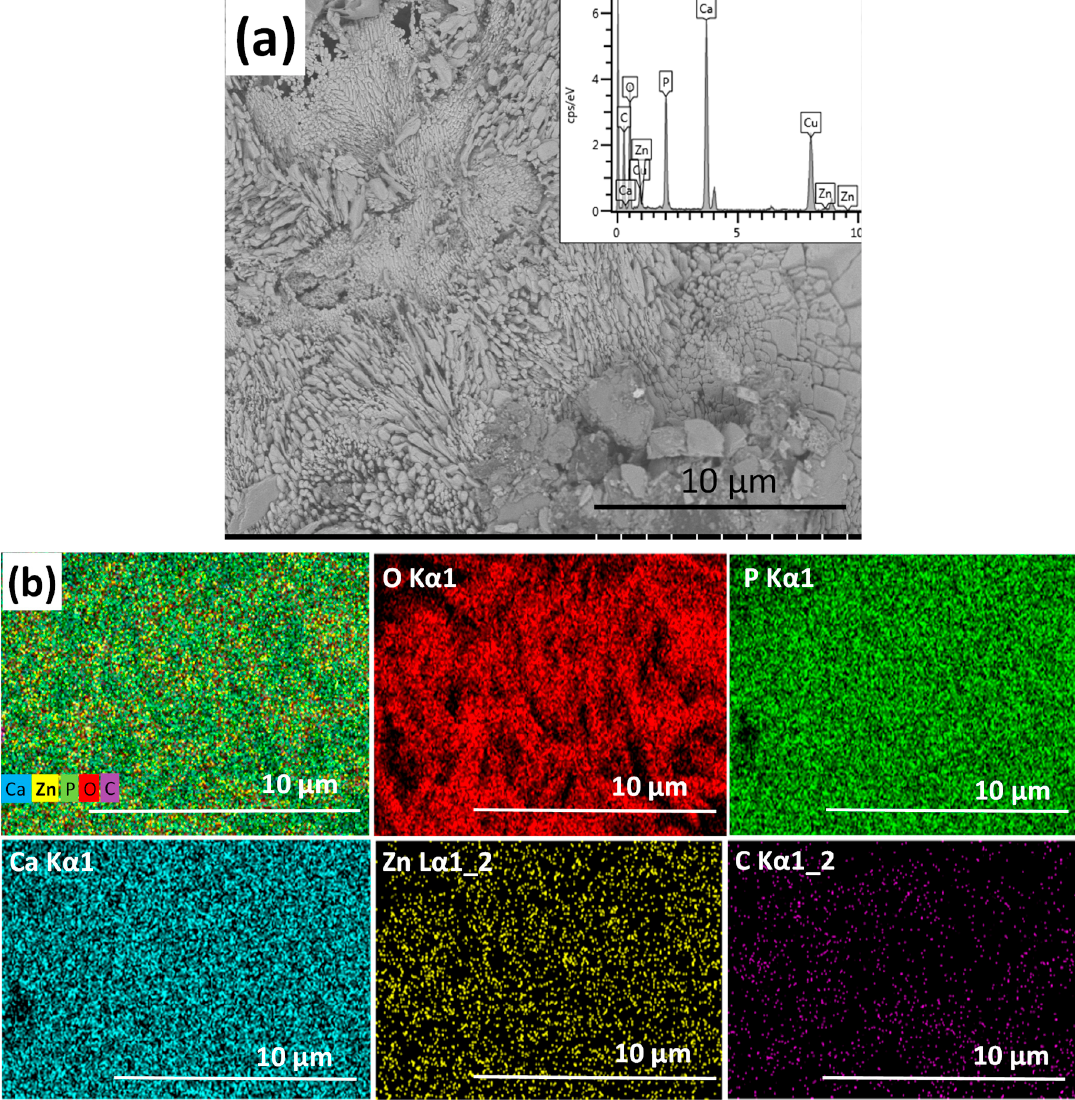
Figure 2. SEM image of zinc-containing CP coating. ( a ) Magnification: 5.0 k, working voltage: 2.0 kV, working distance: 4.1 mm, and the corresponding map sum EDX spectrum (inset) and ( b ) elemental mapping of zinc-containing CP coating.